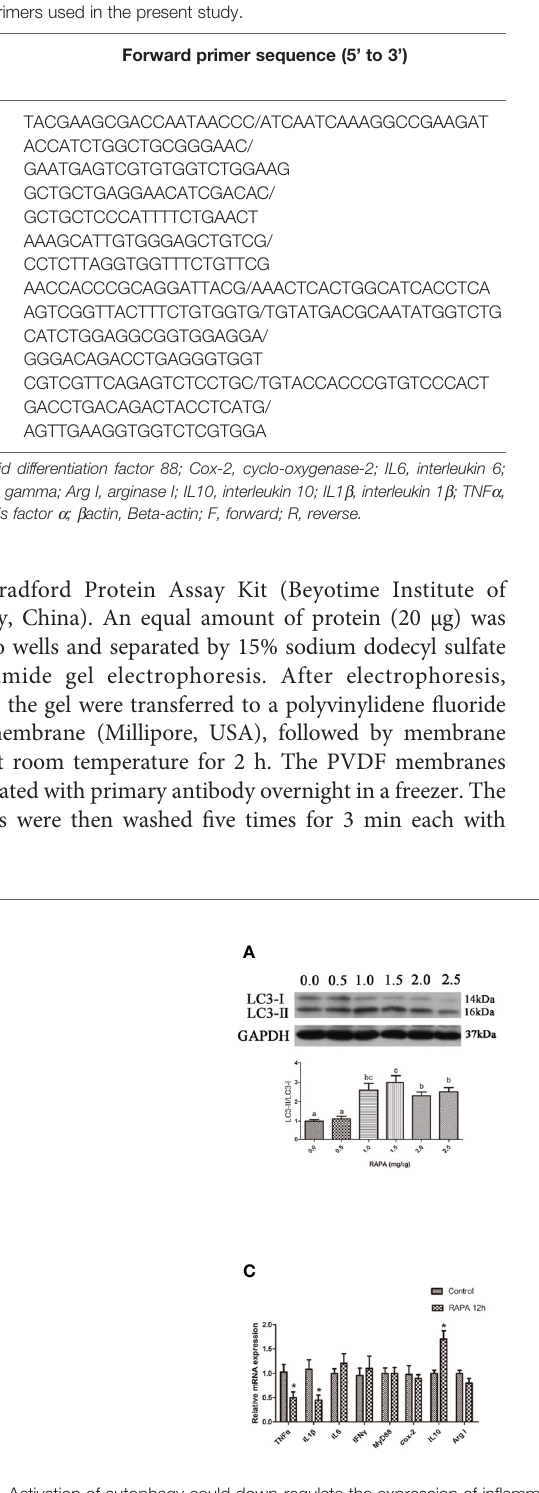
FIGURE 1 | Activation of autophagy could down-regulate the expression of in fl ammatory genes in vivo . (A) The ratio of LC3-II/LC3-I was analyzed by western blots on liver after treatment of different levels of RAPA (n=3). (B) The ratio of LC3-II/LC3-I was analyzed by western blots on liver after treatment of different time of RAPA (n=3). (C) The mRNA expressions of TNF a , IL1 b , IL6, IFN g , MyD88, Cox-2, IL10 and Arg I were analyzed by qRT-PCR on liver after injected with 1.0mg/kg RAPA for 12h (n=6). (D) The mRNA expressions of TNF a , IL1 b , IL6, IFN g , MyD88, Cox-2, IL10 and Arg I were analyzed by qRT-PCR on liver after injected with 1.0mg/kg RAPA for 48h (n=6). Results were represented as means with SEM and signi fi cance was evaluated by one-way ANOVA followed by Tukey ’ s multiple range tests or independent t tests (* P < 0.05). a,b,c Means share a same superscript letter are not signi fi cantly different ( P ≥